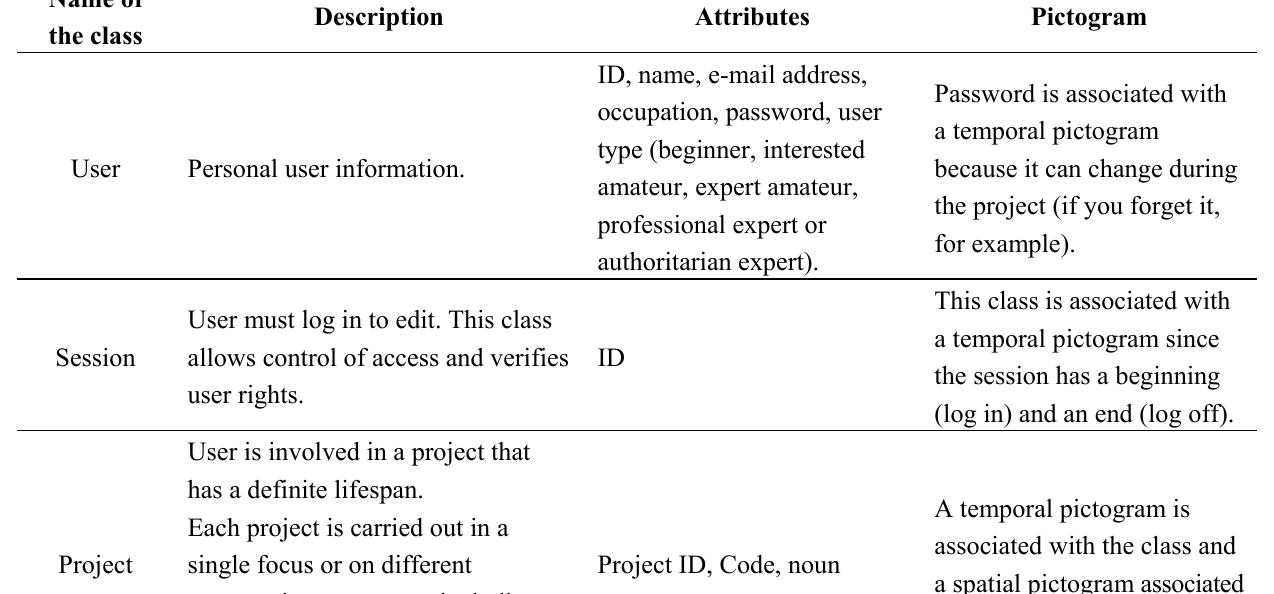
Table 7. Classes of the WikiGIS